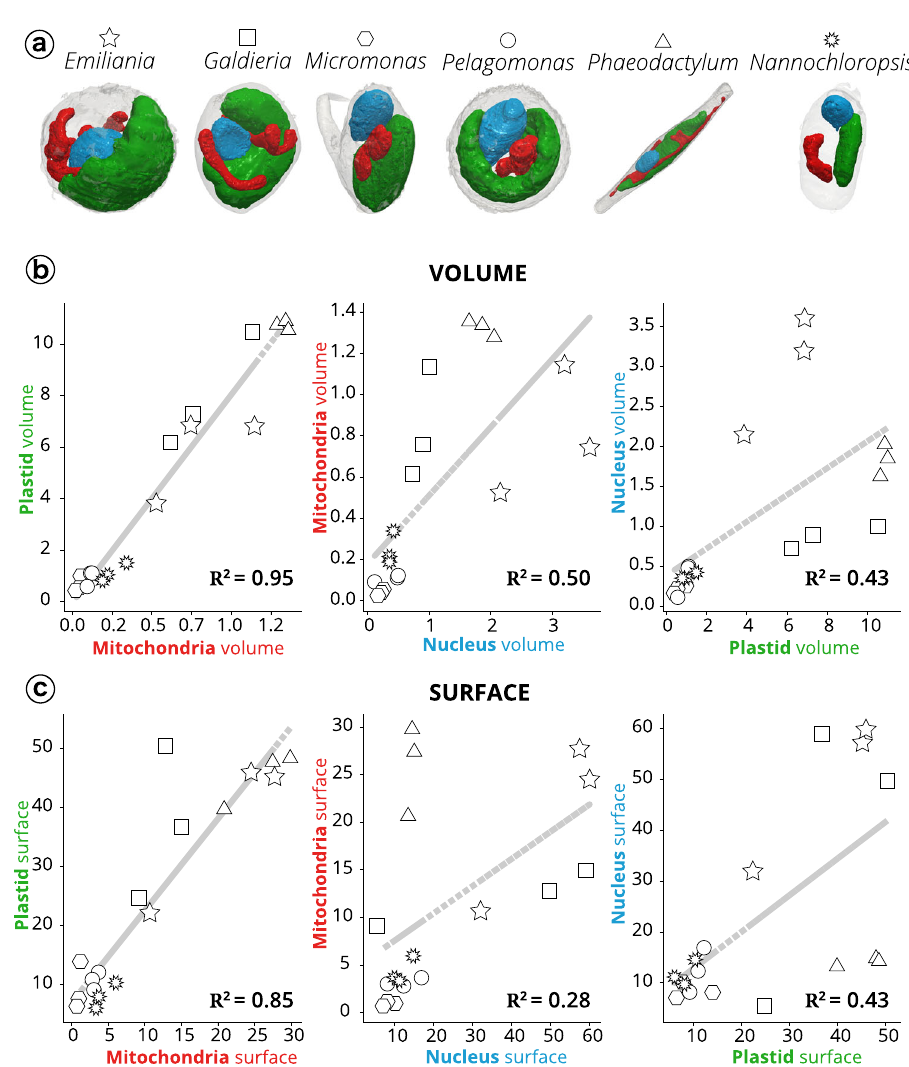
Fig. 3 Morphometric analysis of phytoplankton members. a 3D topology of the main organelles (green: plastids; red: mitochondria; blue: nuclei) in the different cell types. b Volume relationships in different subcellular compartments, as derived from quantitative analysis of microalgal 3D models. c Surface relationships in different subcellular compartments, as derived from quantitative analysis of microalgal 3D models. Three cells were considered for every taxum. Stars: Emiliania; squares: Galdieria ; hexagons: Micromonas ; circles: Pelagomonas ; triangles: Phaeodactylum ; suns: Nannochloropsis . Symbiodinium cells were not considered in this analysis, because their size, which largely exceeds the other (Supplementary Fig. 3), prevents a meaningful analysis of the